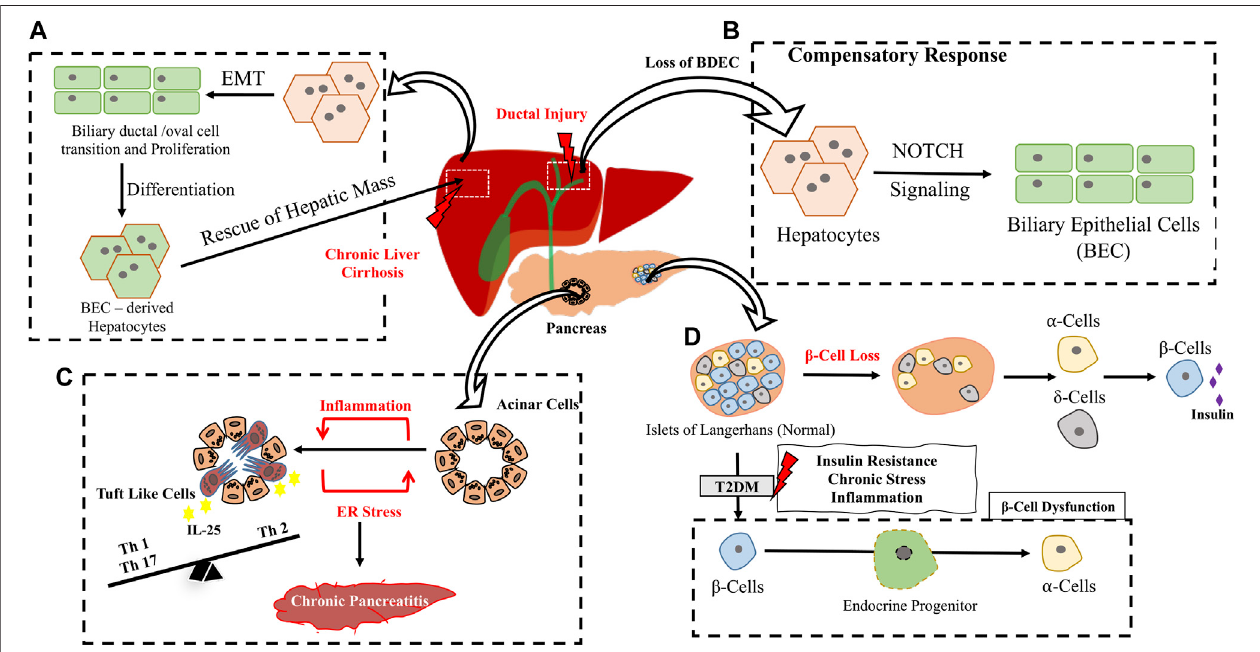
FIGURE 5 | In fl ammation/Injury induced trans-differentiation in Hepato-pancreatic system. (A) Under chronic liver cirrhosis/in fl ammatory conditions, normal hepatocytes from the adjacent region undergoes Epithelial to Mesenchymal Transition (EMT) followed by expansion through a ductal cell transition. BEC derived Hepatocytes replenish hepatic mass. (B) Compensation of BEC loss in chronic ductal injury through a hepatocyte to BEC trans-differentiation involving Notch signaling (C) Fewacinarcellsinthepancreasdirectlytrams-differentiatetoTuftlikeCellsuponChronicPancreatitisshapingadaptiveimmunityintheniche. (D) Lossof β cells resultsinconversionof ⍺ and δ cellsto β celltypetocompensateforinsulinrequirement.ChronicstressprevalentinT2DM,leadsto β celldysfunctionwhichincludesloss of β cell integrity and conversion to ⍺ -cells through an intermediate endocrine progenitor